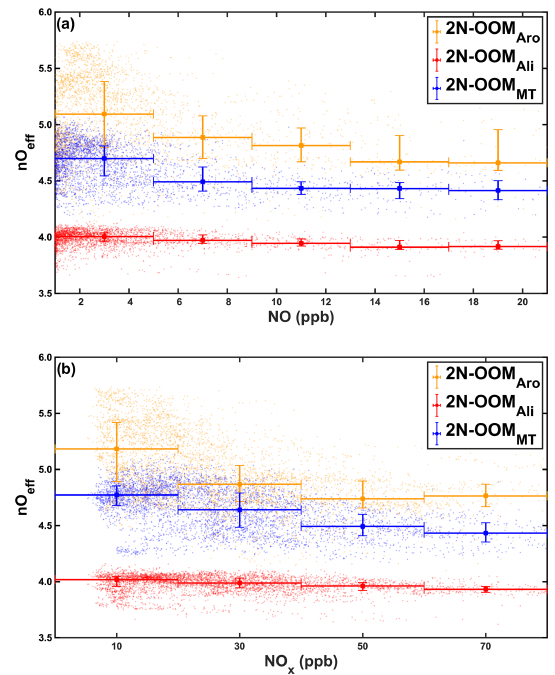
Figure 7. Effective oxygen number (nO eff ) of 2N-OOMs as a func- tion of (a) NO concentration and (b) NO x concentration. The col- ored squares represent the real measurements. The filled markers in- dicate the median values in the range as horizontal error bars show; the vertical error bars denote the 25th- and 75th-percentile